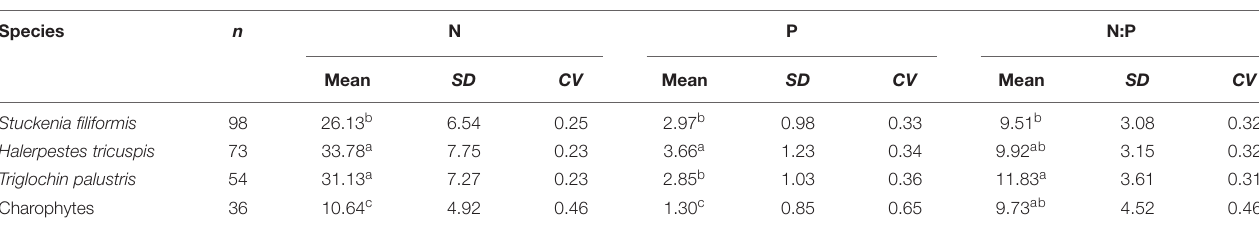
Frontiers in Plant Science |